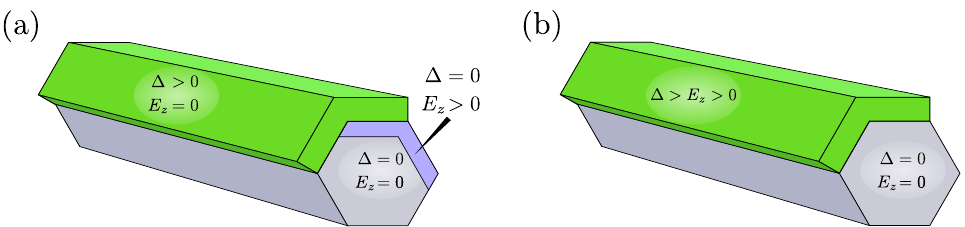
Figure 1: (a) A schematic representation of the experimental setup in Ref. [ 8 ] . The system is a heterostructure consisting of three parts: a semiconducting nanowire, an s -wave superconductor as well as a magnetic insulator. (b) Effective model of the same, a semiconducting nanowire coupled to an s -wave superconductor which features a Zeeman